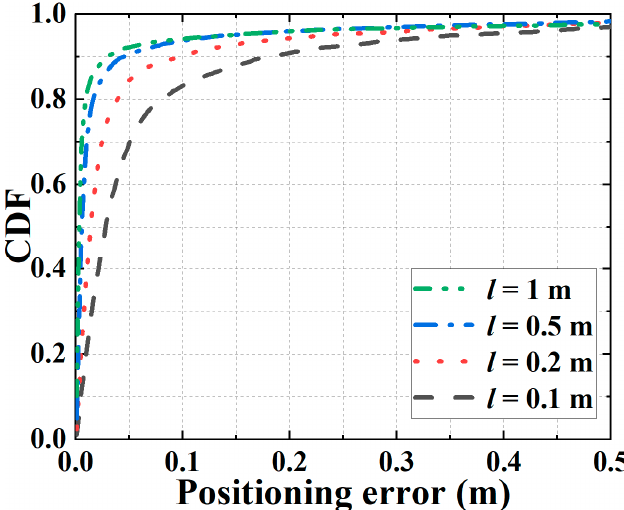
Figure 4. CDFs of 3D positioning errors at (0.5, 1, 1). ( θ = 0°).